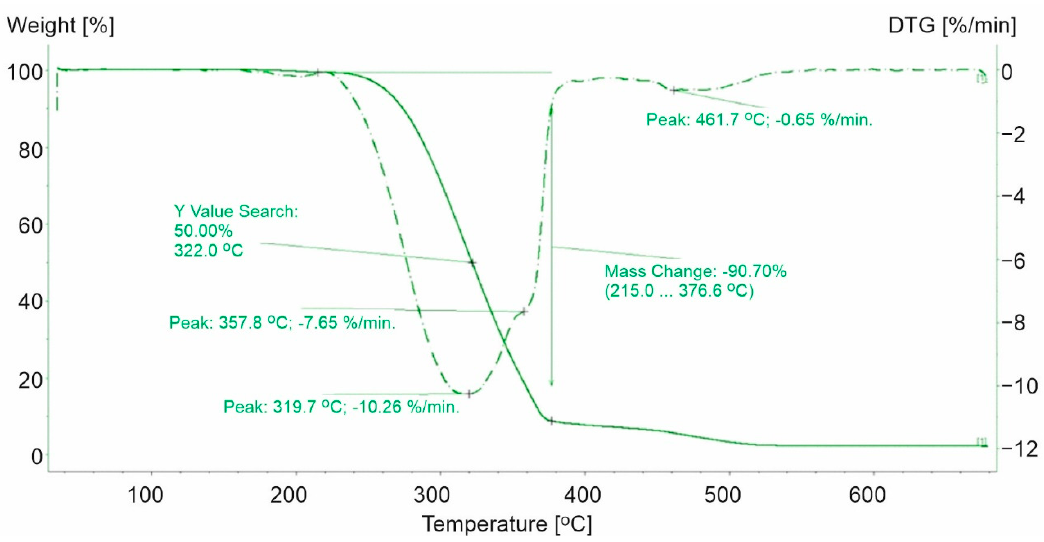
Figure 1. TG and DTG curves for PP ‐ 1. The green line presents TG curve, while the green dot line presents DTG curve.